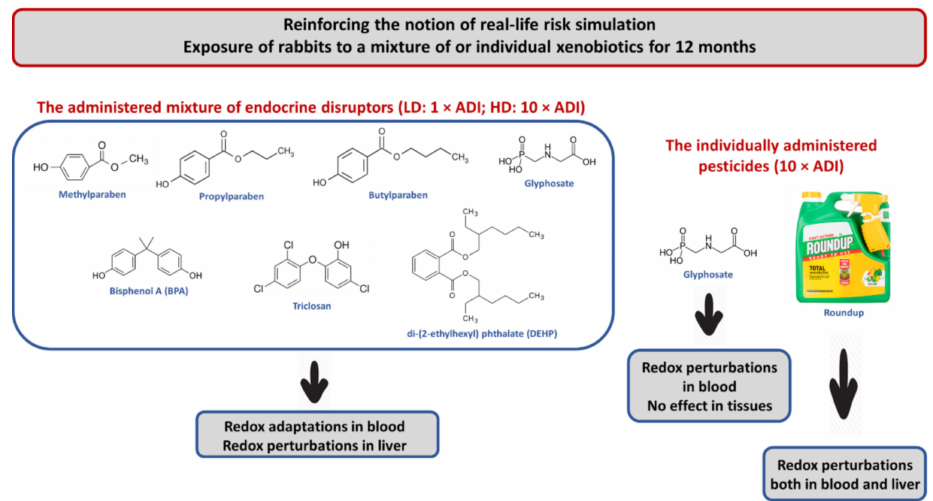
Figure 11. A conceptual illustration of the main findings of the present study. ADI: Acceptable daily intake; LD: Low dose; HD: High